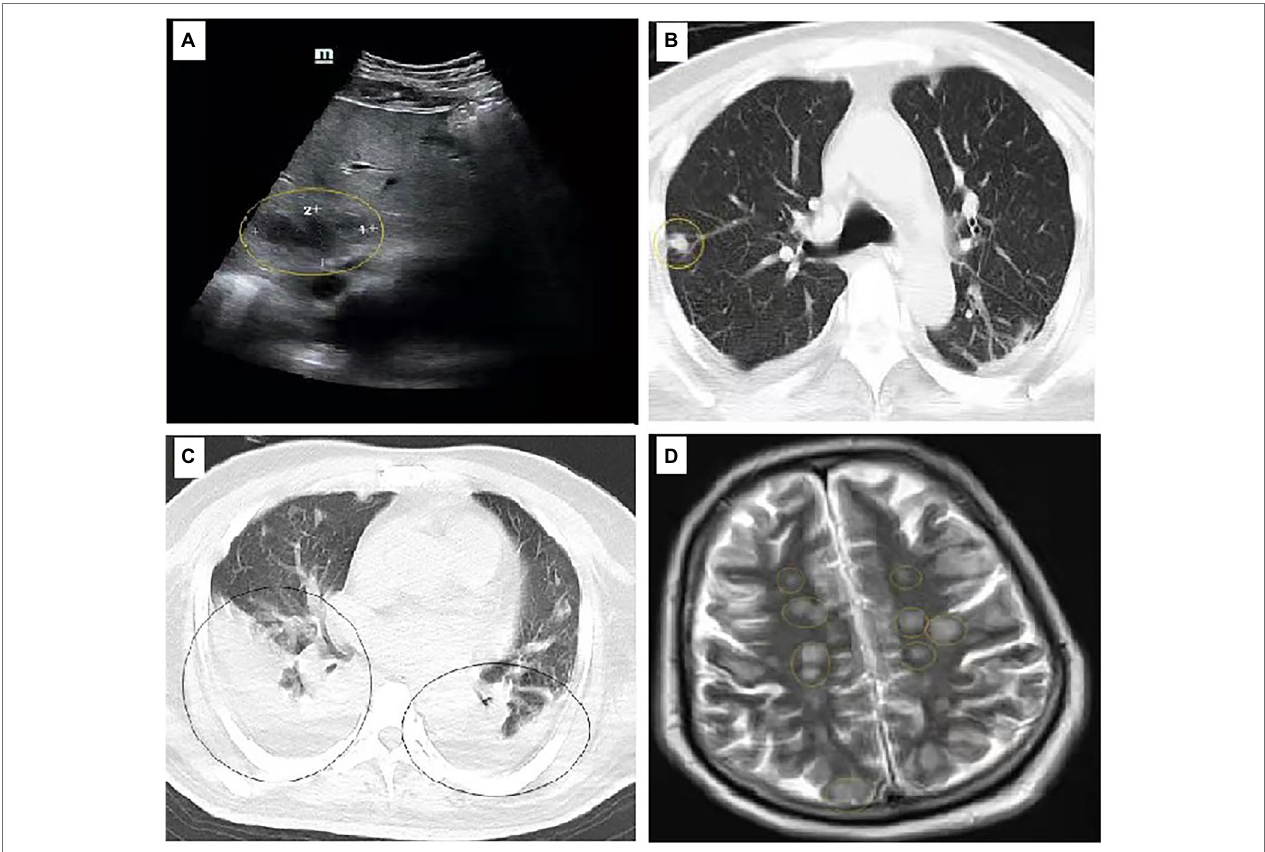
FIGURE 1 | Image findings in this case. (A) Abdominal ultrasound showed the presence of intrahepatic abscess; (B,C) An computed tomography (CT) scan revealed an abscess of right lung and bilateral pleural effusion. (D) The nuclear MRI showed multiple brain abscess. Yellow circles refer to the abscesses and black circles refer to the presence of pleural